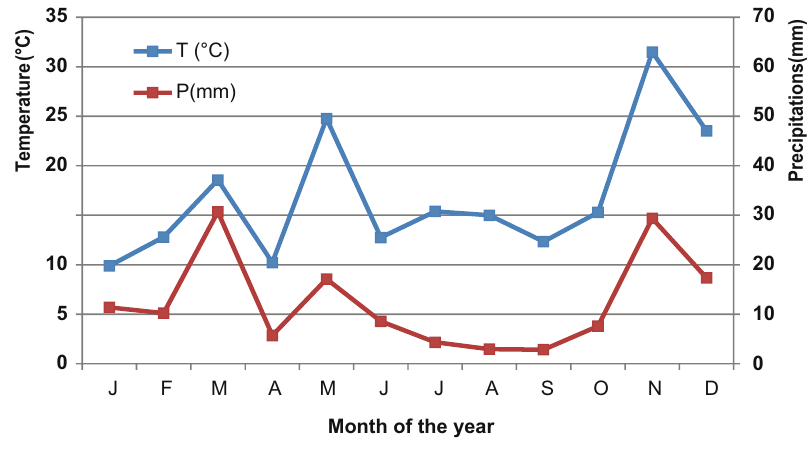
Figure 2: Gaussen and Bagnouls diagram of the studied region ( 2015 – 2016 ) .